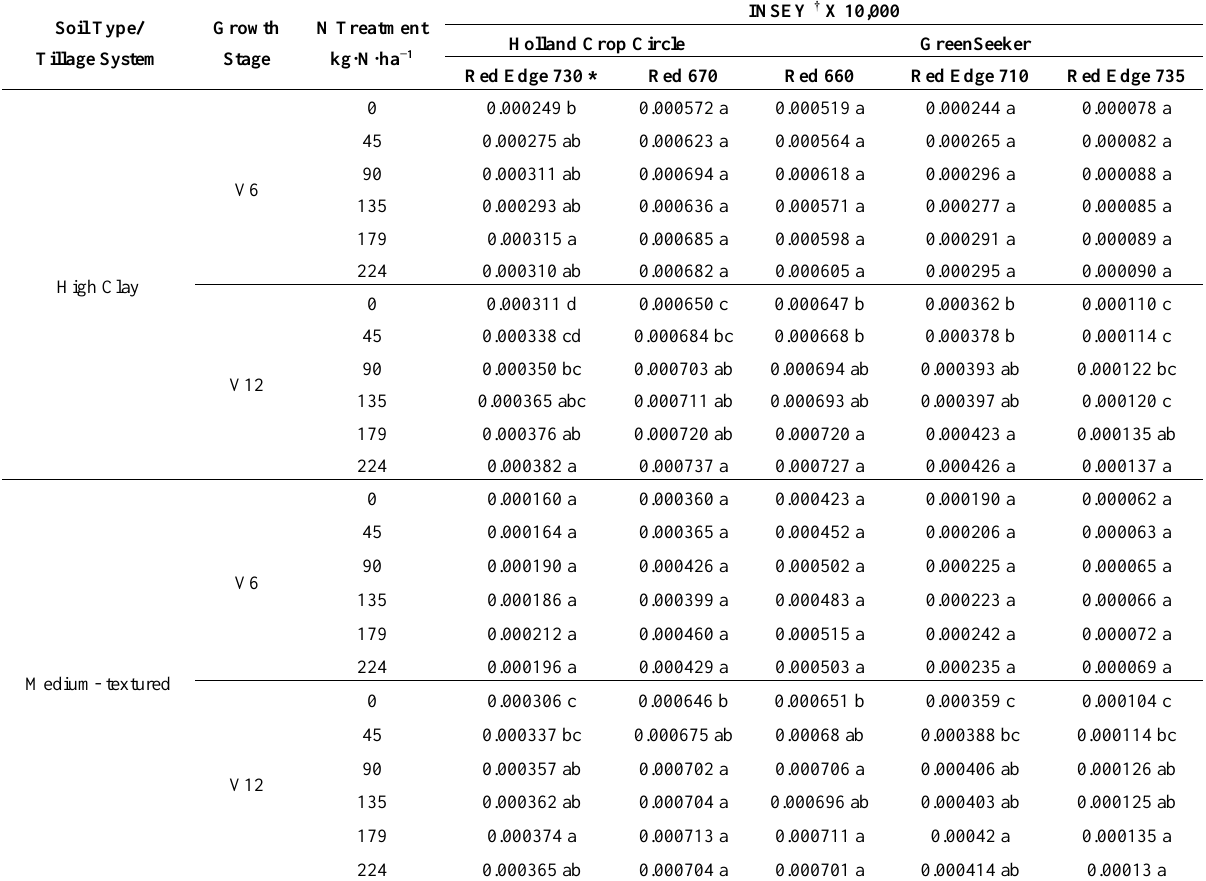
Figure 2. Variation of INSEY for corn at high clay conventional-till sites calculated from CC active-sensor spectra (670 nm and 730 nm) and GS spectra (660 nm, 710 nm and 735 nm) with N rate compared to yield variation with N rate at V6 (upper left) and V12 (lower left ). Trend for INSEY at three N rates (control, 134∙kg∙ha −1 and 224∙kg∙ha −1 ) over the five wavelengths represented as a continuous spectrum is displayed at V6 in figures at ( upper right) and at V12 in ( lower right) . Table 6. Treatment differences between INSEY developed from five wavelengths utilizing two ground-based active-optical sensors in eastern high clay ( n = 143) and eastern medium-textured ( n = 71) categories under conventional tillage at two corn growth stages from nitrogen rate